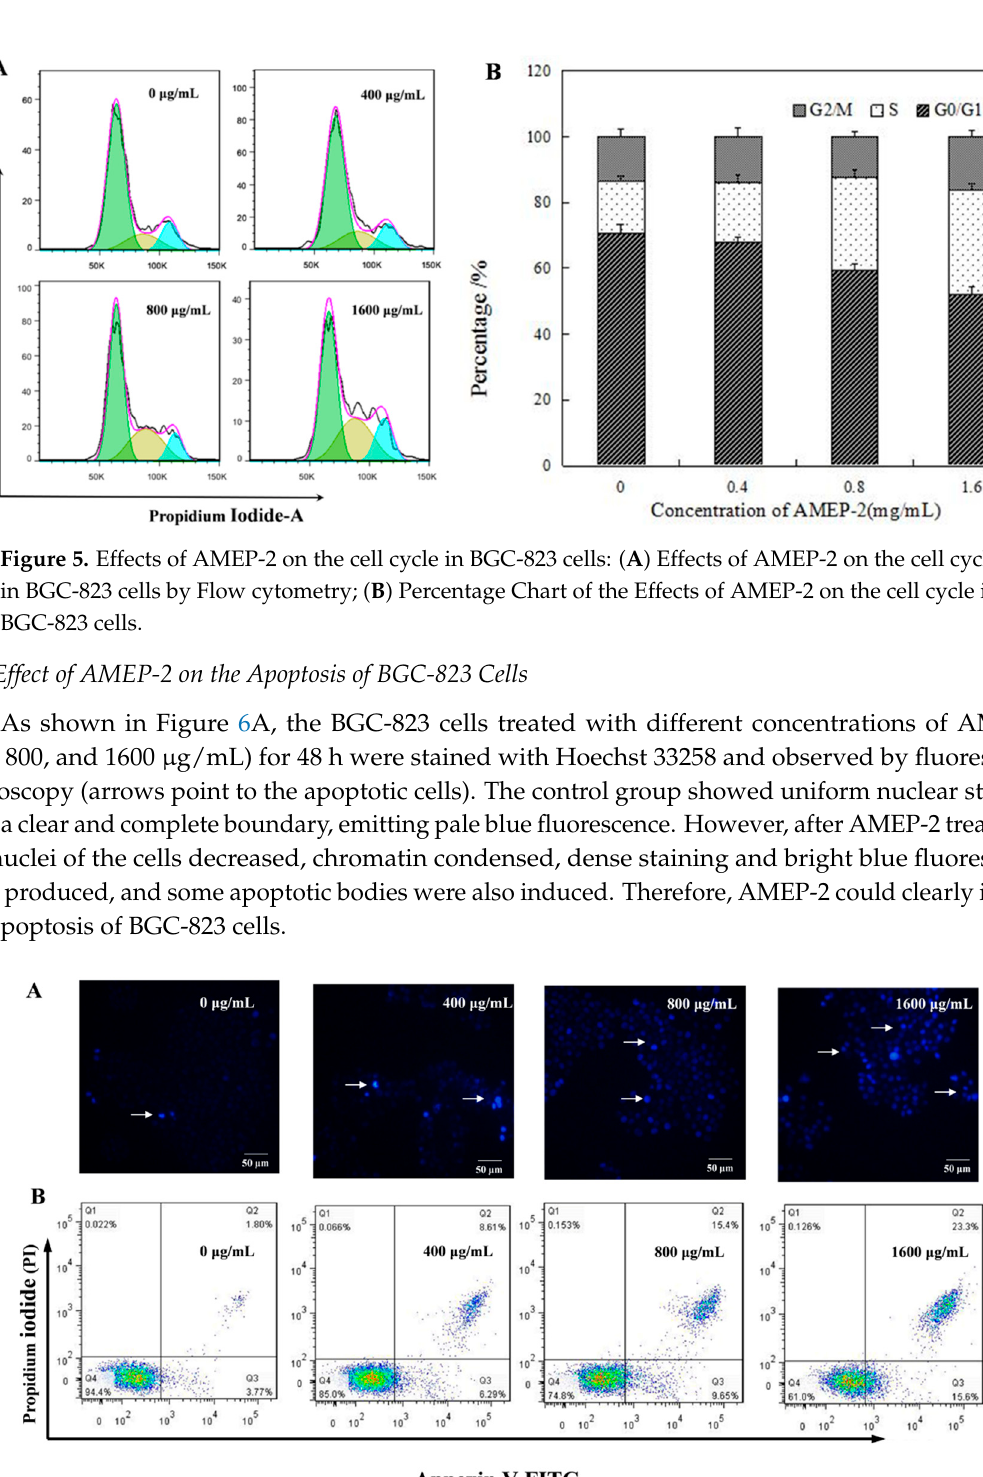
Figure 6. Effect of AMEP-2 on the apoptosis of BGC-823 cells: ( A ) Hoechst 33258 staining. BGC-823 cells were treated with 0, 400, 800 and 1600 μ g/mL AMEP-2 for 48 h, Bar = 50 μ m; and ( B ) Annexin